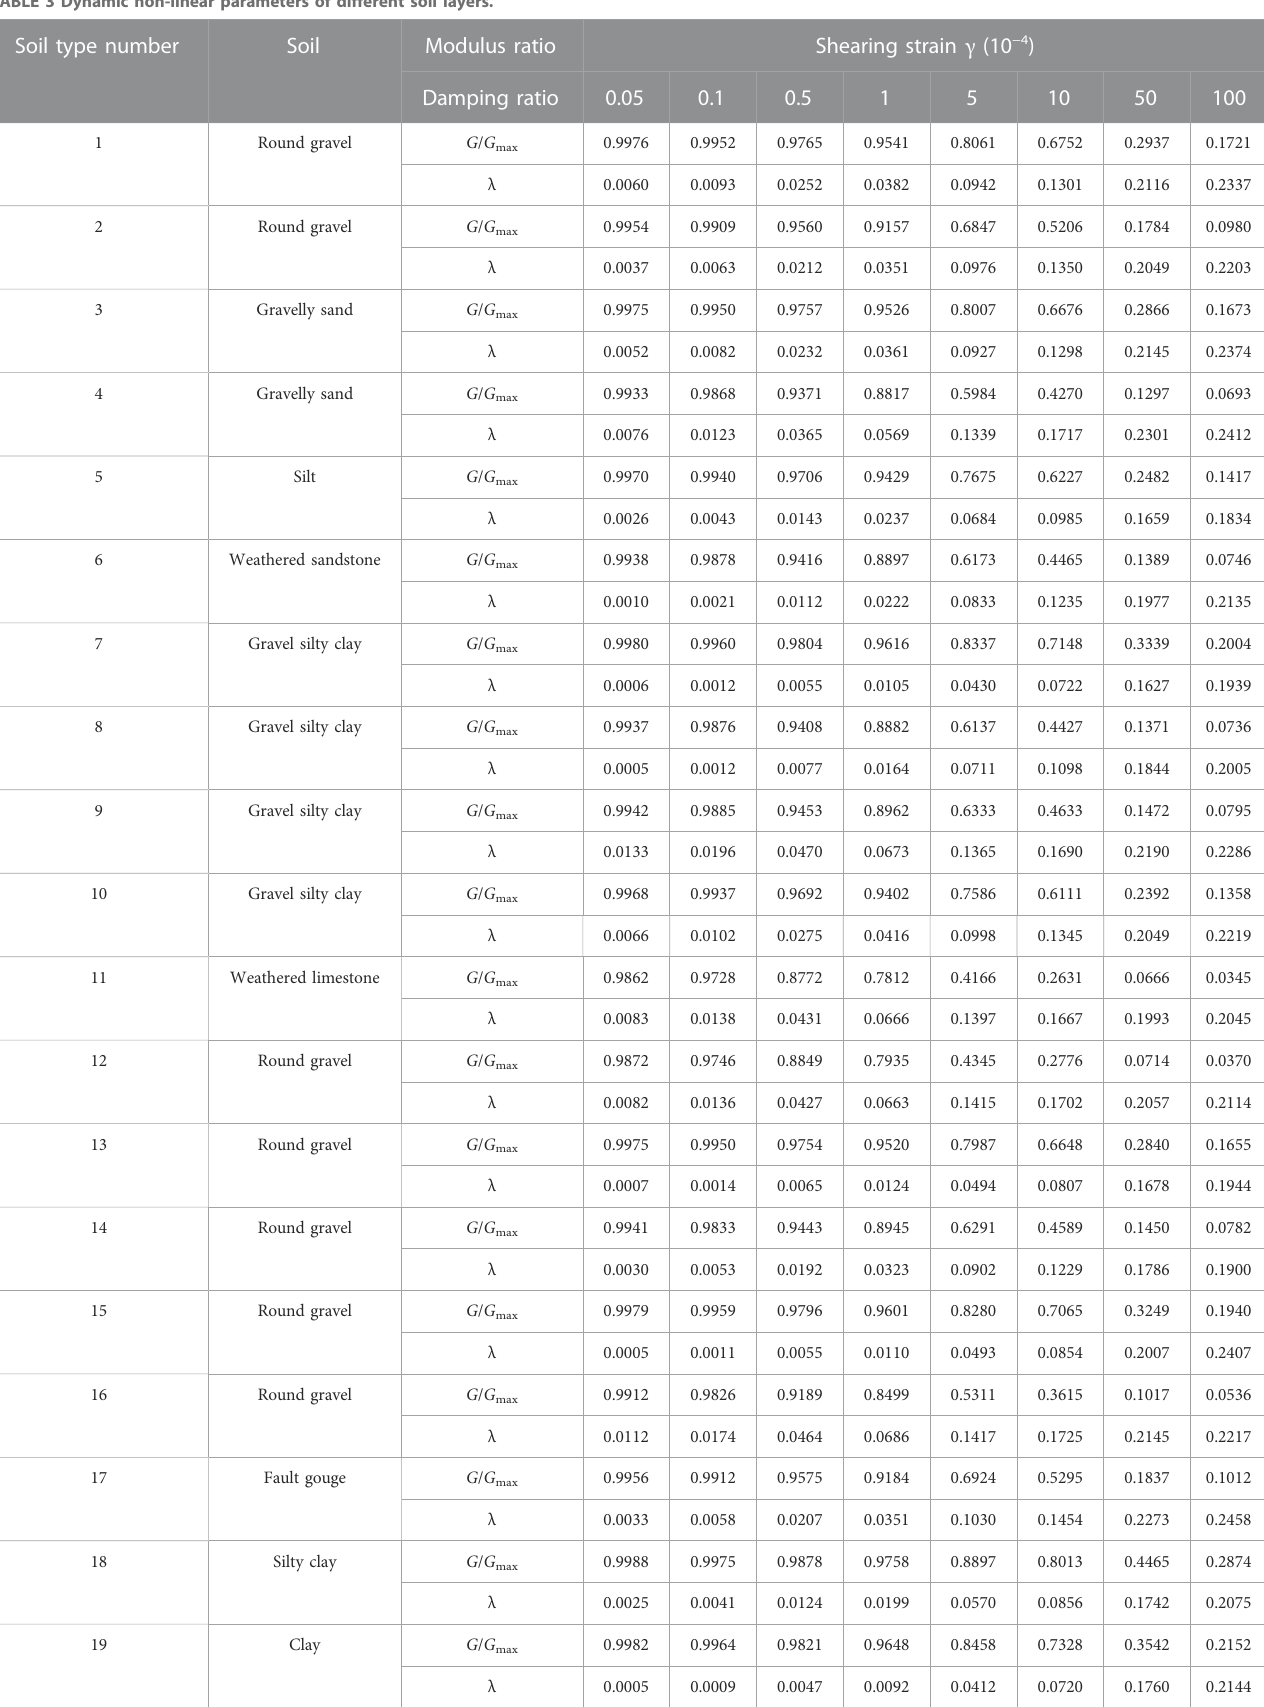
TABLE 3 Dynamic non-linear parameters of different soil layers. Soil type